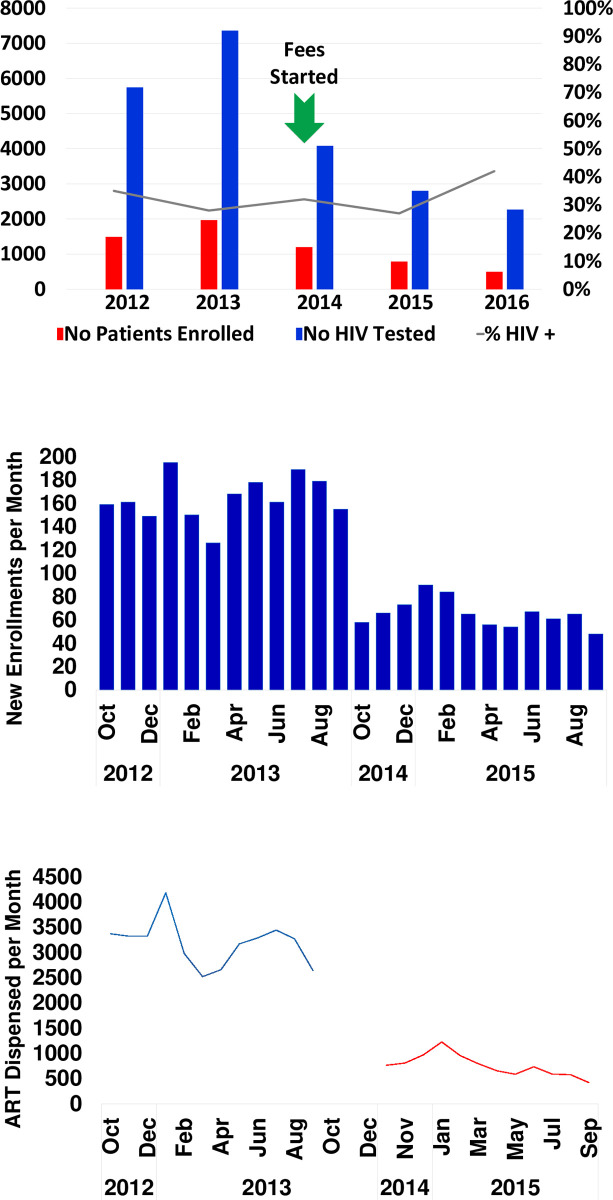
Declines in patient enrollment, HIV testing, and ART dispensing after user fees instituted in a Nigerian clinic.This shows the number of patients enrolled in the HIV clinic by year, as well as the number of HIV tests performed, and proportion testing positive. (A) Yearly trends in HIV testing and patient enrollment (B) Monthly trends in new patient enrollment (C) Monthly trends in doses of ART dispensed. No = Number.